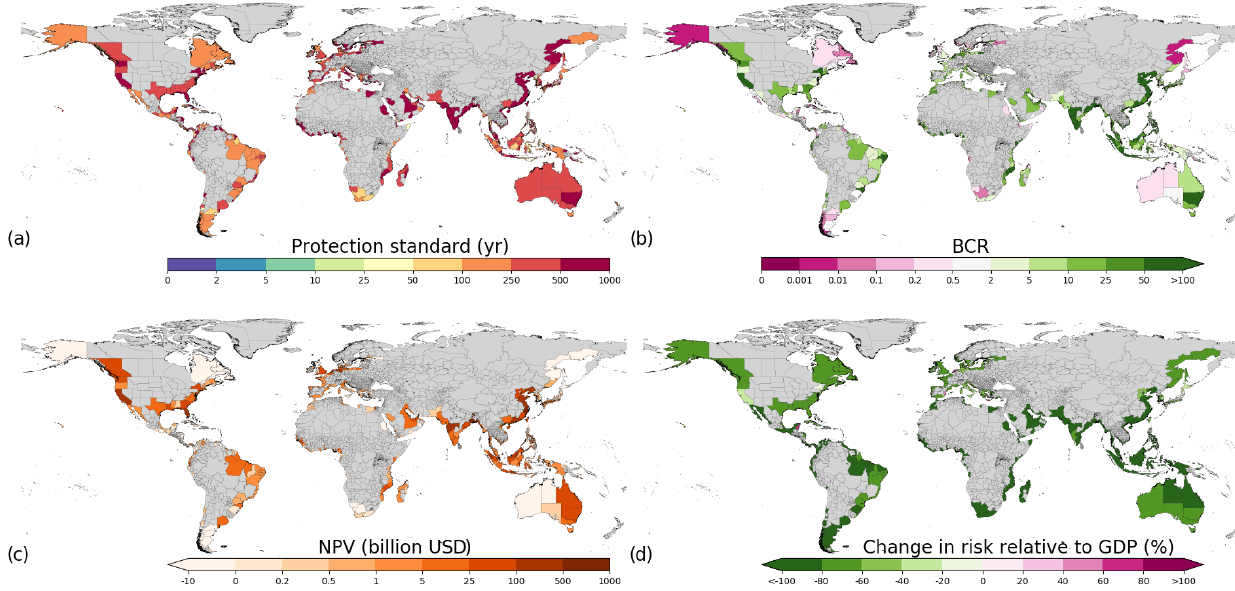
Figure 6. Absolute-risk-constant adaptation objective results of (a) protection standards, (b) BCRs, (c) total NPV, and (d) change in risk relative to GDP for RCP4.5–SSP2. Regions with no data are indicated in grey.